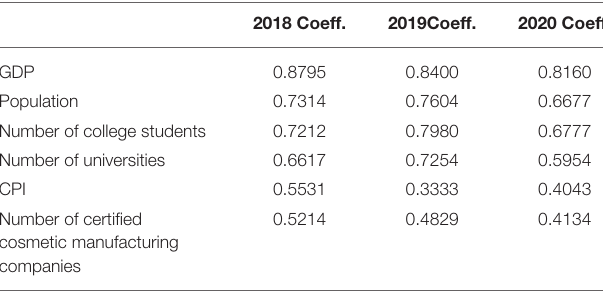
TABLE 2 | Correlation between the number of participants and socioeconomic factors across 31 provinces of China. 2018